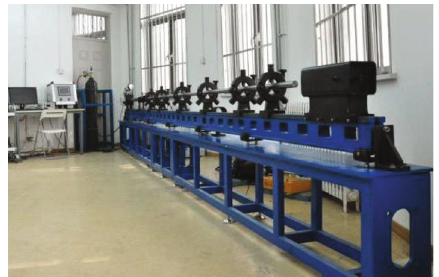
Figure 2: SHPB experimental